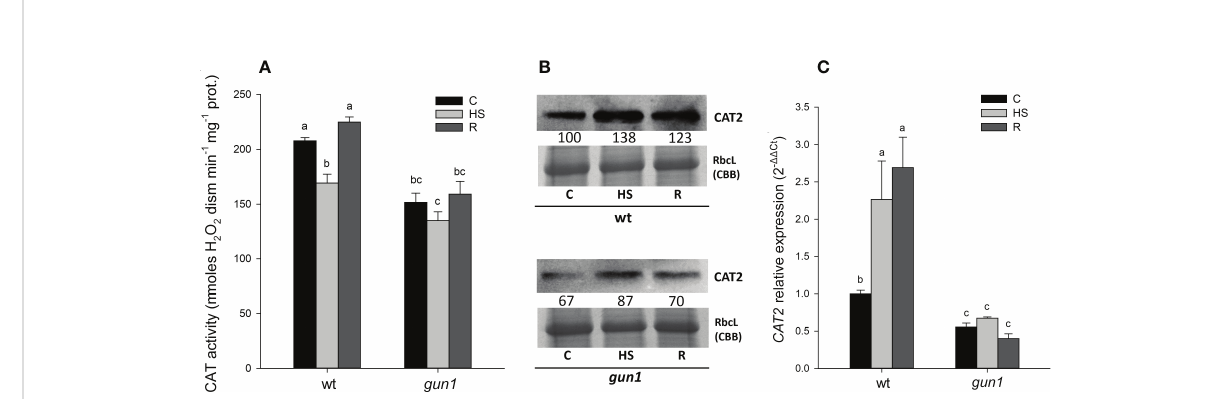
FIGURE 7 Catalase (CAT) behavior in 15 days-old wt and gun1 plantlets, grown at control temperature (C) or subjected to Heat Stress (HS; 2 hours at 45° C), followed by short recovery (R; 3 hours at 22°C). (A) Total CAT activity. Values are the means ± standard errors (SE) of fi ve independent experiments. Letters indicate signi fi cant differences obtained by one-way ANOVA test (P< 0.05). (B) Representative image from three independent experiments of CAT2 immunoblotting, each well was loaded with 30 m g of proteins. CBB staining of the gel is shown as equal loading control. Quanti fi cation of signals (by Quantity One ® ) relative to the wt in control conditions (100%) is provided below the panel. (C) Relative expression of CAT2 . The expression level of CAT2 was normalized to that of Ubiquitin 10 (At4g05320) and Actin8 (At1g49240) as internal references. For each sample, gene expression was related to the wt in control conditions (C). Values are the means ± SE from three independent experiments, with three technical replicates for each experiment. Letters indicate signi fi cant differences obtained by one-way ANOVA test (p<